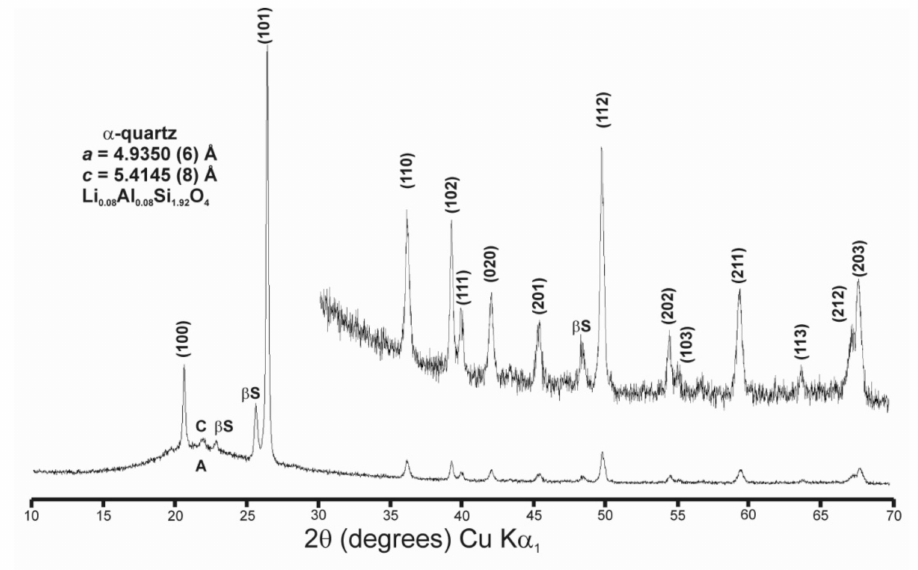
Figure A4. Powder XRD pattern of α -quartz Li 0 . 08 Al 0 . 08 Si 1 . 92 O 4 (Si/Al = 25/1) with a = b = 4.9350 (6) Å and c = 5.4145 (8) Å with (hkl) peaks from the P 3 2 2 1 space group symmetry, synthesized at 850 ◦ C and 1 atm. File 16331 is α -SiO 2 in ICSD database with a = b = 4.921 Å, c = 5.400 Å, α = 90 ◦ , β = 90 ◦ , and γ = 120 ◦ , which is very similar to the low content Li–Al quartz here synthesized. The sample was crystallized from the amorphous precursor gel at 850 ◦ C and 1 atm. Some additional peaks from cristobalite SiO 2 (C) and β -spodumene ( β S) are also marked, and the residual contents of amorphous material (A) is also